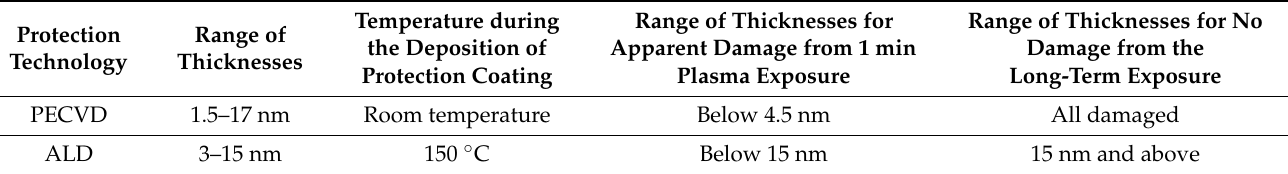
Table 2. Comparative data for AlOx ALD and SiNx PECVD layers tested with O 2 plasma